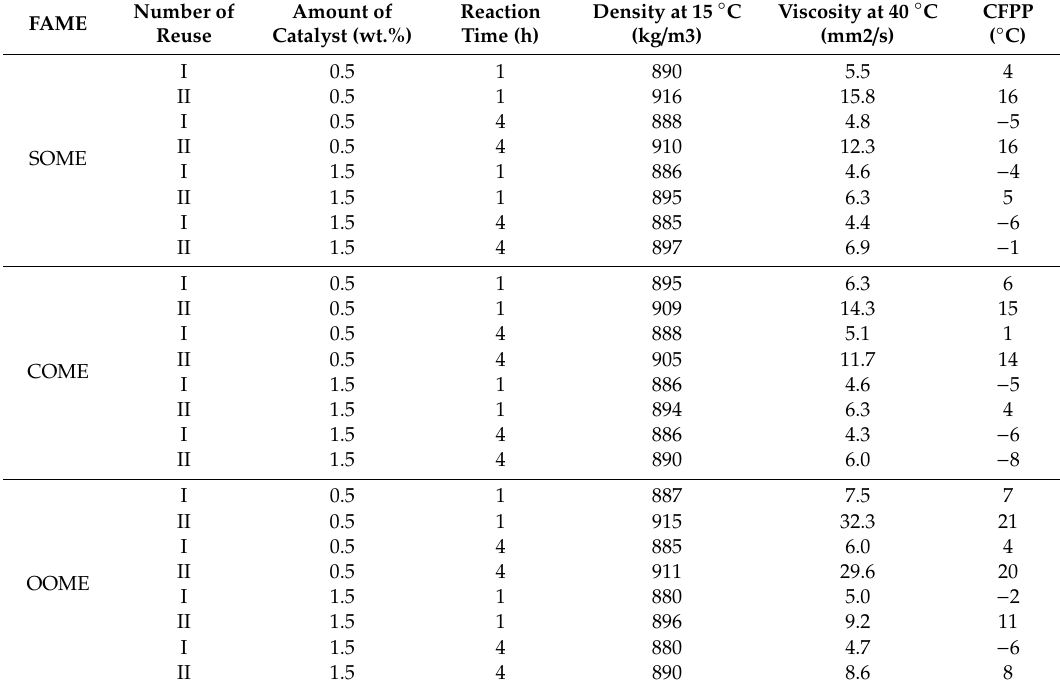
Table 3. The e ff ect of EvTr / AC as catalyst on properties of ROME, SOME, COME and OOME.